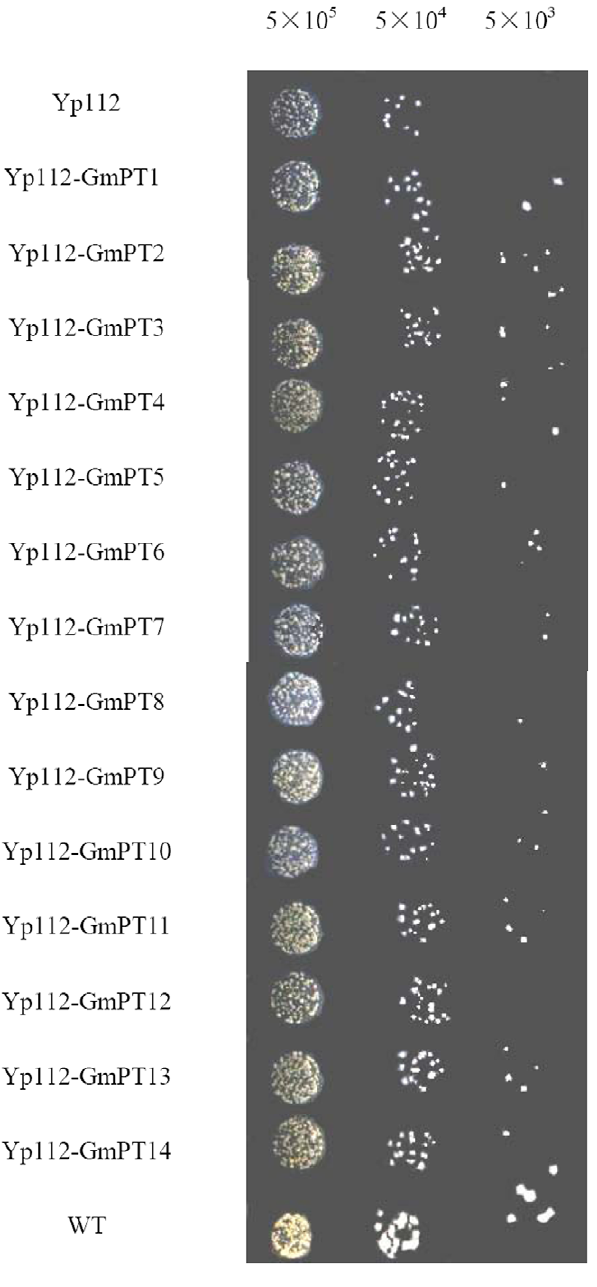
Figure 2. Complementation of a yeast inorganic phosphate (Pi) transport mutant by GmPTs genes. Yeast MB192 cells harboring either an empty expression vector (control) or the candidate Pht1 ORF(open reading frame), transformants were grown in YNB medium to an OD600 < 0.8, then washed by 3% glucose with centrifugation at 1500 g, 4 u C, and suspended in phosphate free YNB medium to OD600 < 1.0. Different number cells (5 6 10 5 , 5 6 10 4 , 5 6 10 3 ) were applied to Pi- limiting medium (20 m M, pH 6.0) then incubated at 30 u C for 3 d.